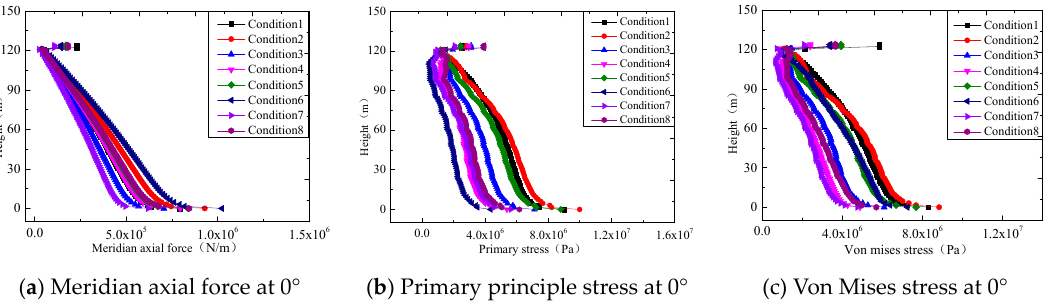
Figure 24. Changes of internal stresses on the tower body with heights under different conditions.